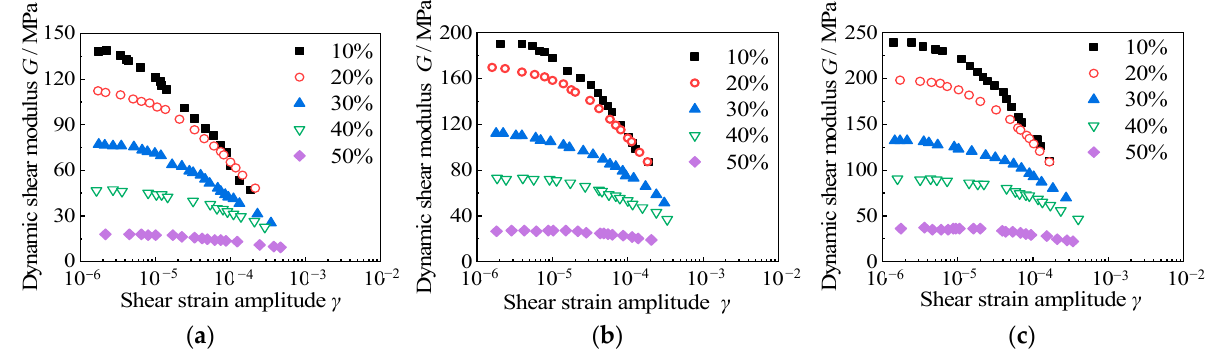
Figure 18. The relationship between the dynamic shear modulus and shear strain amplitude of RCS soil with different rubber contents. ( a ) σ 'm = 50 kPa, C = 3.5 g/100mL, ( b ) σ 'm = 100 kPa, C = 3.5 g/100 mL, ( c ) σ 'm = 150 kPa, C = 3.5 g/100 mL.